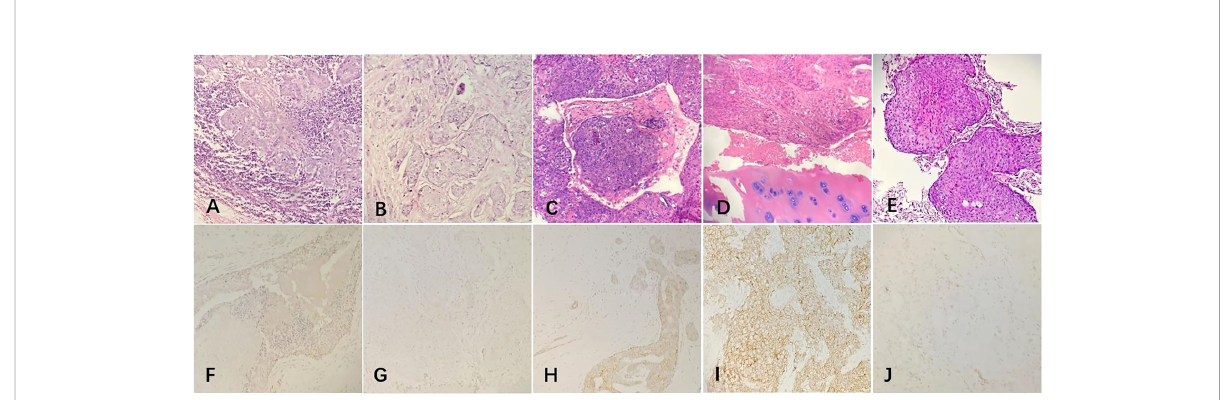
FIGURE 2 The postoperative pathological examination with hematoxylin and eosin (HE) staining and immunohistochemical (IHC) staining of the tumor. (A, B) Microscopically, the ductal cells in the mammary tumor area showed squamous degeneration and the lymph nodes were invaded by tumor cells (20x). (C, D) Histological fi ndings with HE staining showed that the chest wall tumor was a moderately differentiated squamous cell carcinoma and the bone tissue was invaded by tumor cells(20x). (E) Histological fi ndings with HE staining showed that the lung tumor was a metaplastic squamous cell carcinoma(20x). (F – I) IHC staining of the primary tumor in 2015. (F) ER negativity (20×). (G) PR negativity (20×). (H) HER2 receptor negativity (20×). (I) EGFR positive expression (20×). (J) IHC staining of the lung tumor showed that the PD-L1